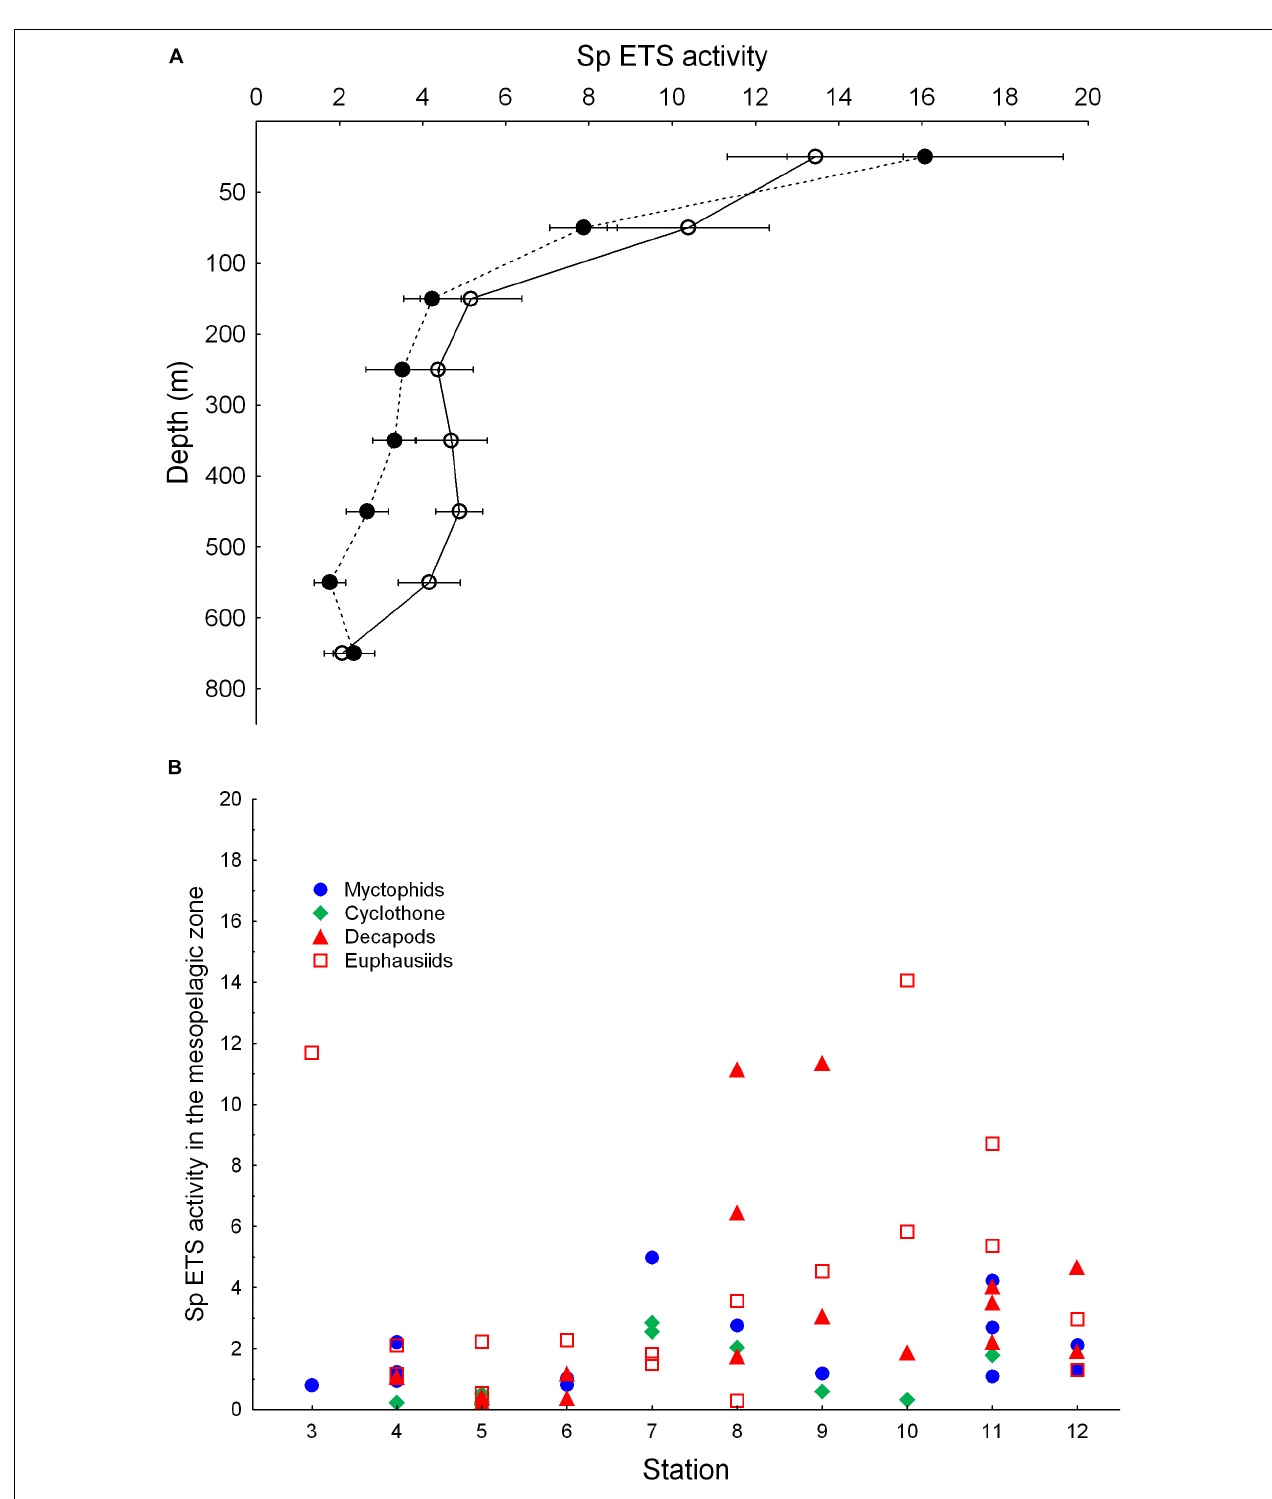
FIGURE 7 | (A) Vertical distribution of average zooplankton specific ETS activity (in µ lO 2 · mg protein − 1 · h − 1 ) during daytime (empty dots) and nighttime (black dots). Observe the higher ETS activity during daylight hours in the mesopelagic zone. (B) Specific ETS activity (in µ lO 2 · mg protein − 1 · h − 1 ) of fishes and crustaceans sampled in the mesopelagic zone along the transect. Organisms captured in the whole water column were analyzed for ETS and the activity calculated for the mesopelagic temperature given in Table 1 .